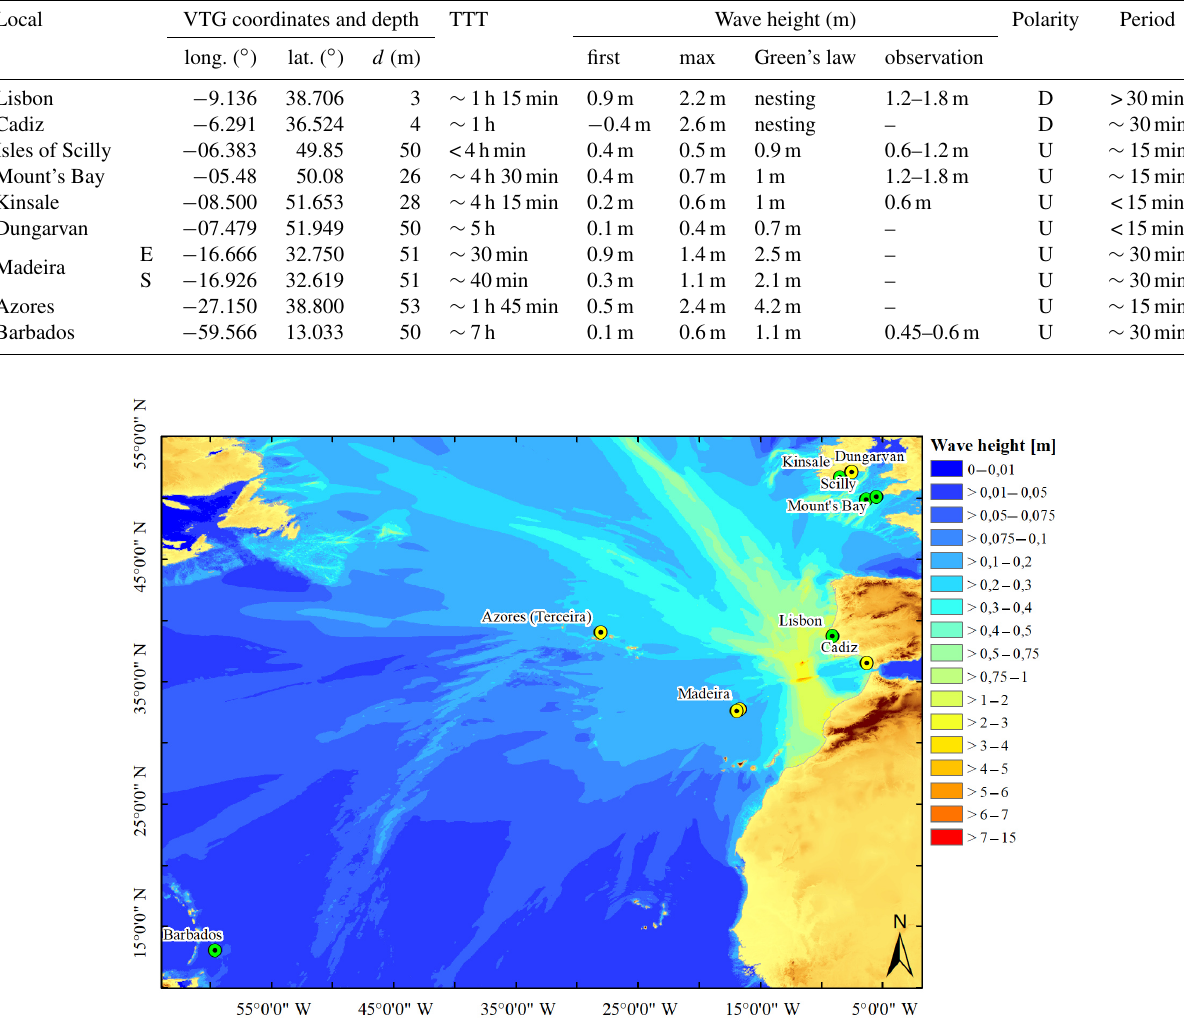
tures (Martínez-Loriente et al., 2013) and 85 km northeast of the epicentre suggested by Baptista et al. (2006) (Fig.